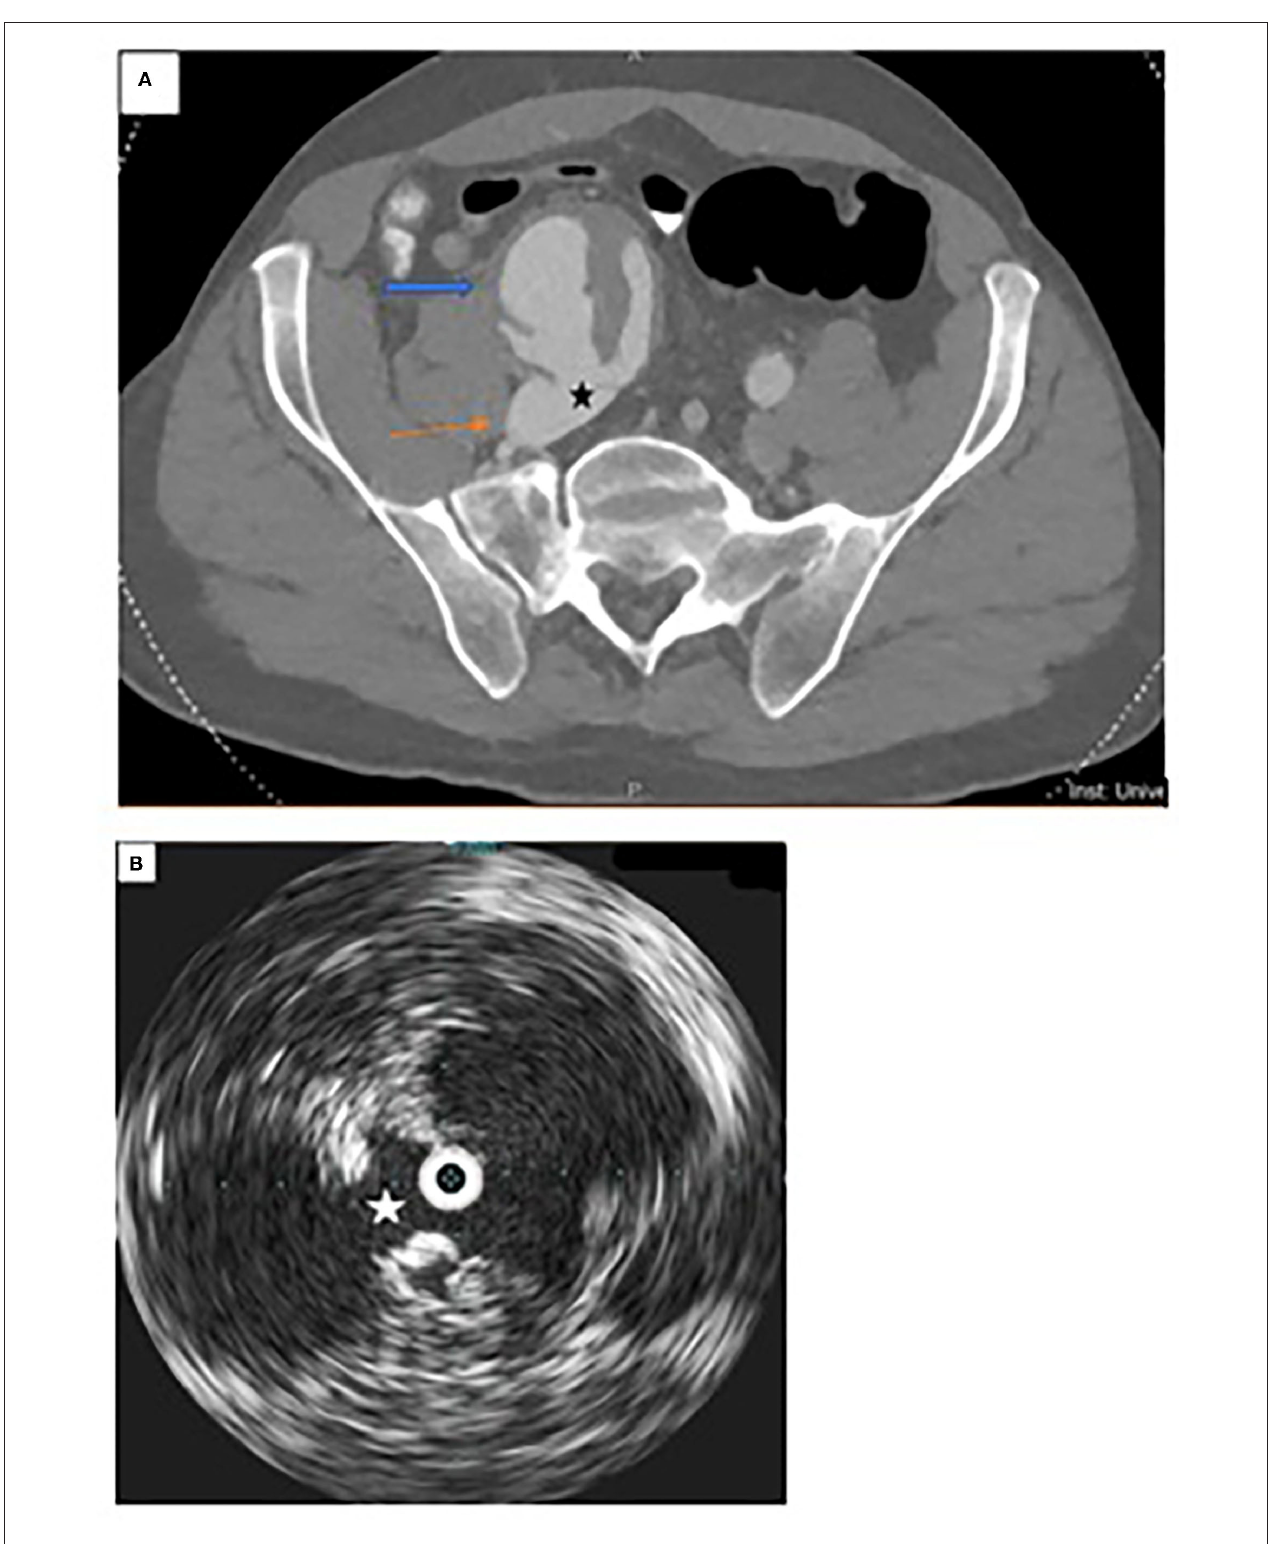
FIGURE 2 | Additional imaging of fistula. (A) CT angiogram demonstrating arterial-venous fistula between the common iliac artery (blue arrow) and common iliac vein (orange arrow). (B) Intravascular ultrasound demonstrating arterial-venous fistula between the common iliac artery and common iliac vein.